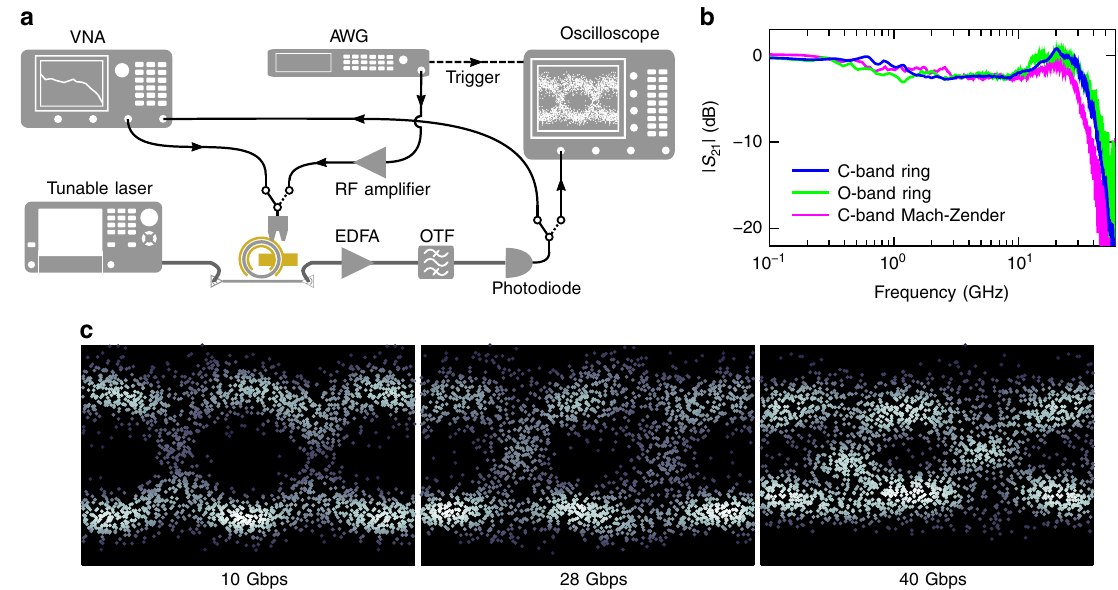
Fig. 3 High-speed measurements. a Sketch of the setup used for small signal measurements (solid path in the switches) and for the eye diagram measurements (dashed path). VNA: vector network analyzer, AWG: arbitrary waveform generator, OTF: optical tunable fi lter. b Electro-optic small signal ( S j j parameter) measurement of several modulators. c Eye diagrams of a C-band ring modulator, measured with a non-return-to-zero scheme (2 9 − 1 21 pseudorandom binary sequence) and a peak-to-peak drive voltage of 4.2 V